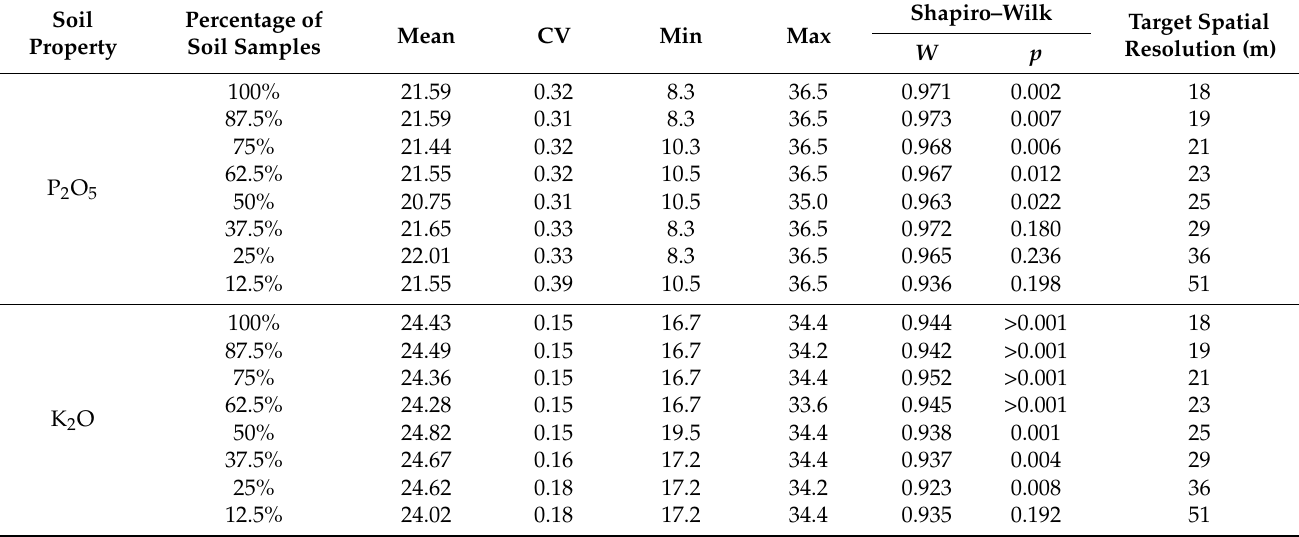
Table 2. Descriptive statistics and Shapiro–Wilk test results of soil